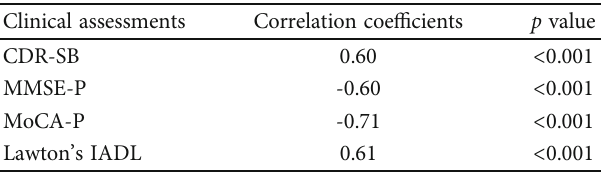
Table 3: Correlation of AD8 – P scores with other cognitive and functional assessments.